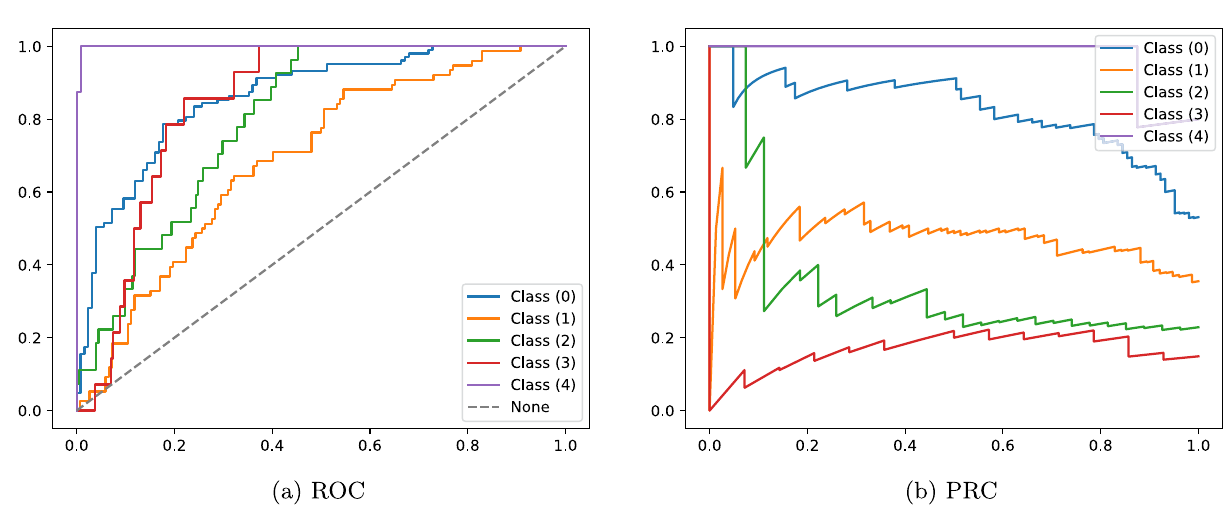
Figure 3. Receiver-operator-curve (ROC) and precision-recall-curve (PRC) of the classifier for each of the five aggregated mNAPSI